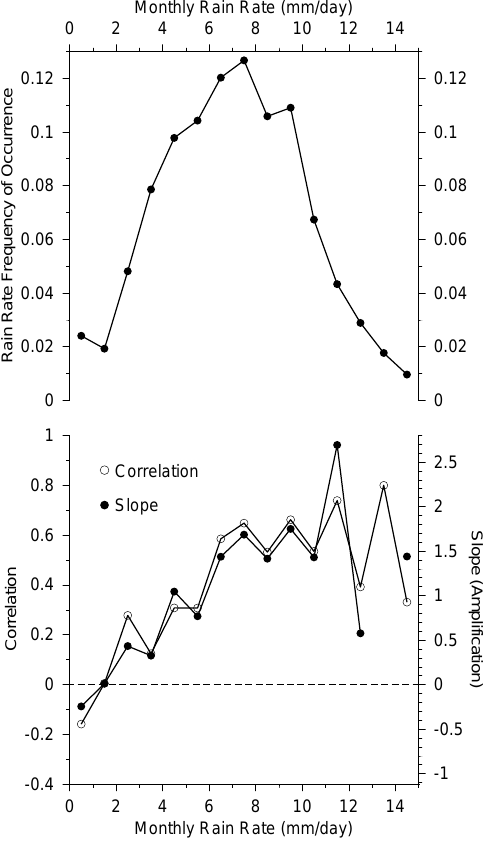
Fig. 4. (upper) This plot shows the relative frequency of occurrence of monthly mean rain rates from 1999–2008, using TRMM 3B42 rain rates averaged over a 2 ◦ × 2 ◦ box centered at each radiosonde location. (lower) The curve with open circles shows the correlation between the near surface (below 1 km ) and 10 km monthly mean temperature anomalies of a radiosonde station, as a function of the average rain rate in a 2 ◦ × 2 ◦ box centered at each station. The curve with open circles shows the slope of a regression of the 10 km monthly mean temperature anomalies against the near surface temperature anomalies, as a function of the local rain rate.